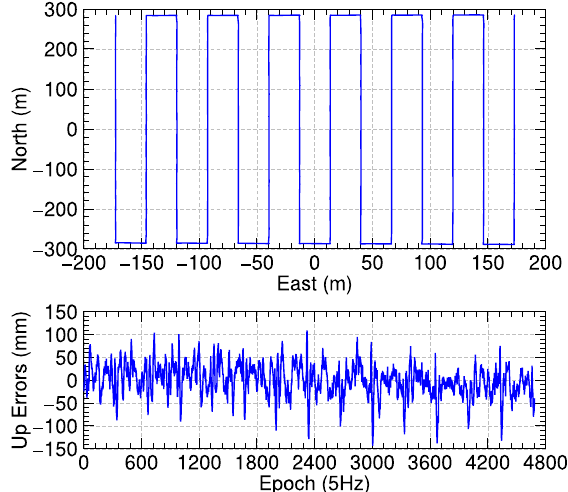
Figure 12. Trajectory of the UAV after data processing.